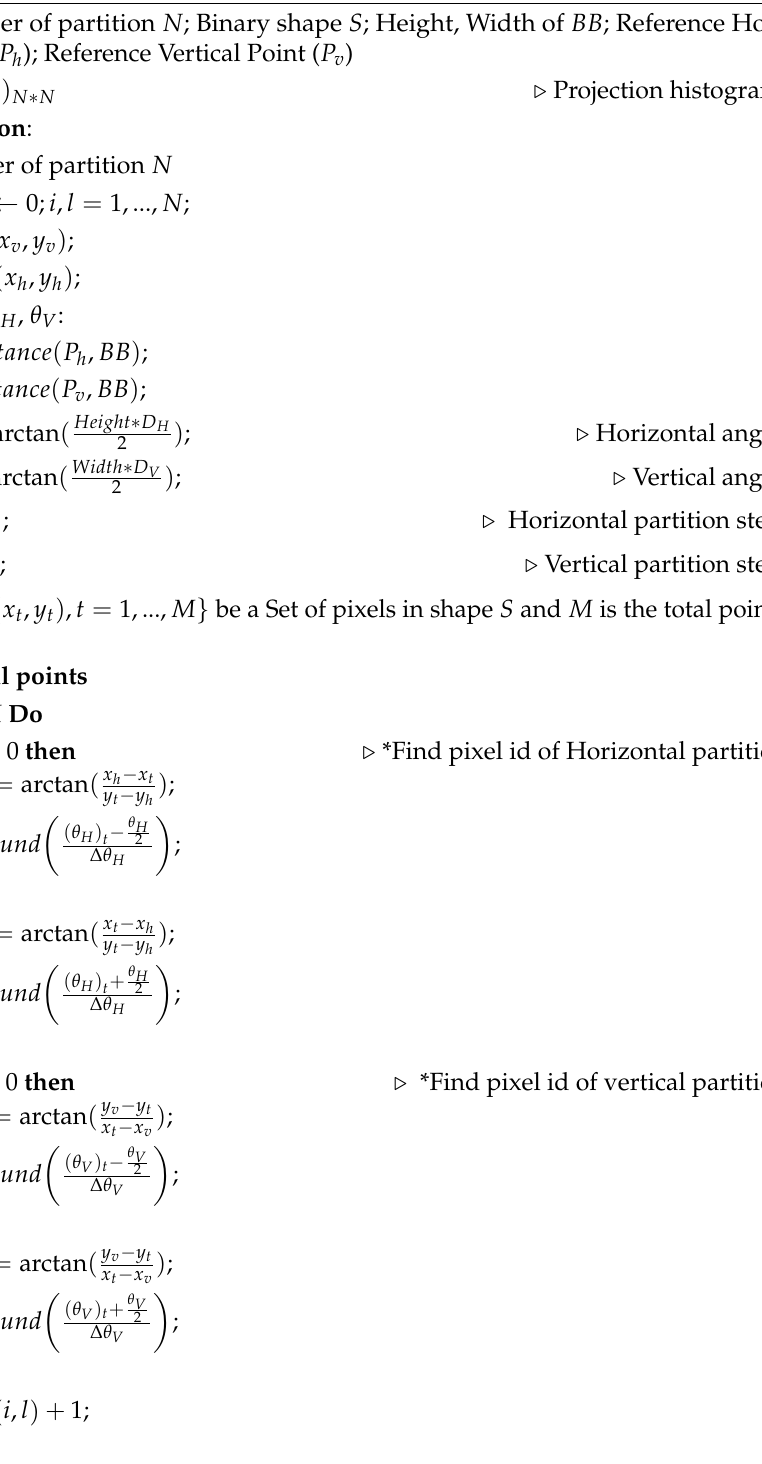
Algorithm 1 Our proposed projection histogram